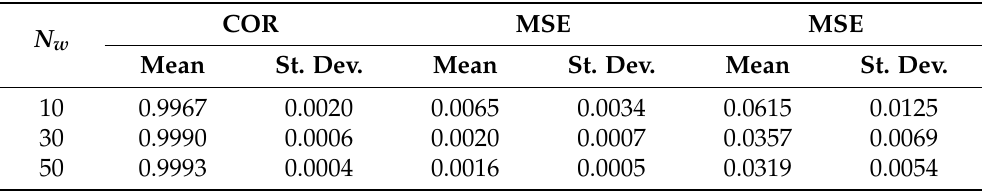
Table 2. COR, MSE, and MAE results for the datasets with the cases N w = 10,30,50. We present the mean and standard deviations of 30 repetitions for each